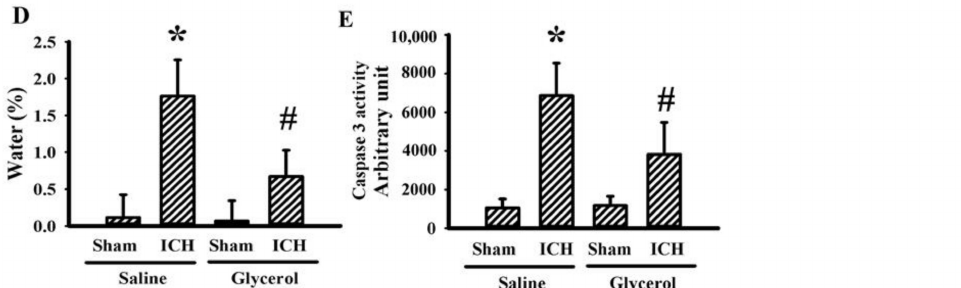
Figure 1. Glycerol alleviated hemorrhagic stroke brain injury. ICH and sham rats were intraperitoneally injected with saline or glycerol and housed for an additional 24 h. ( A ) Neurological deficits were evaluated by neurological score. ( B ) Representative photographs show histological examination of hematoma. ( C ) The percentage of hematoma in the ipsilateral striatum is depicted. ( D ) The water content differences between ipsilateral and contralateral striatum were measured. ( E ) Proteins were extracted from the ipsilateral striatal tissues and subjected to the measurement of caspase 3 activity. * p < 0.05 vs. sham/saline and # p < 0.05 vs. ICH/saline, n = 8.